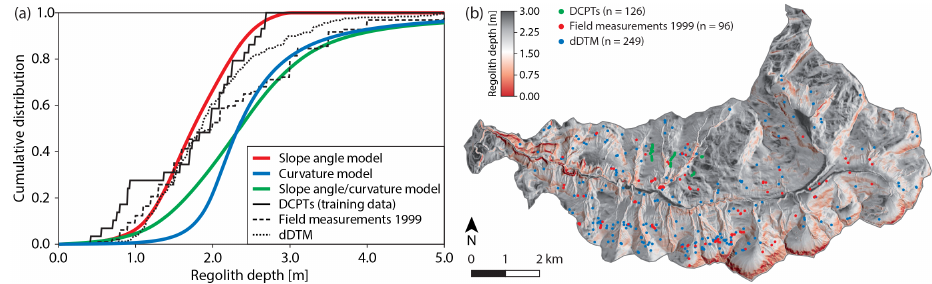
Figure 5. Cumulative distribution of d max derived from observations and models (a) and the resulting regolith depth map (b)